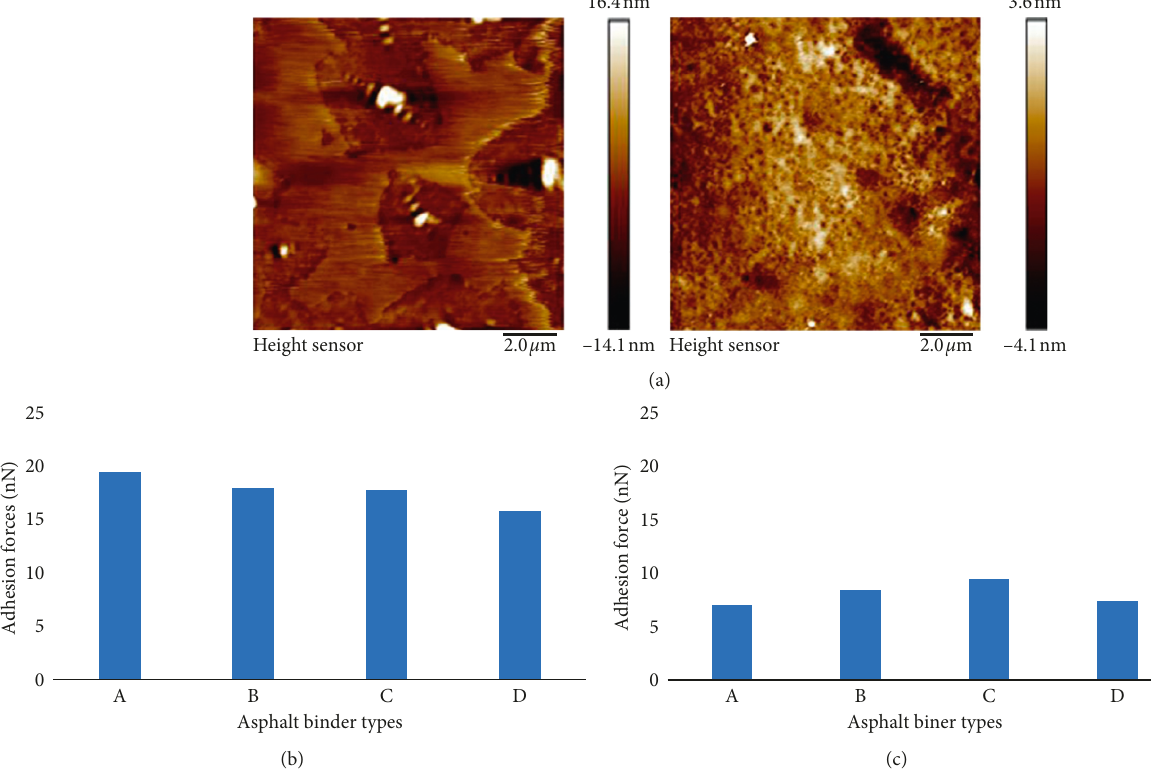
Figure 21: (a) Topographic image of asphalt sample with varying height, (b) adhesion force values (in nN) obtained in raised area from different samples, and (c) adhesion force values (in nN) obtained in recessed area. The Figures 21(b) and 21(c) is reproduced from Yu et al. [51] (under the creative commons attribution license/public domain).